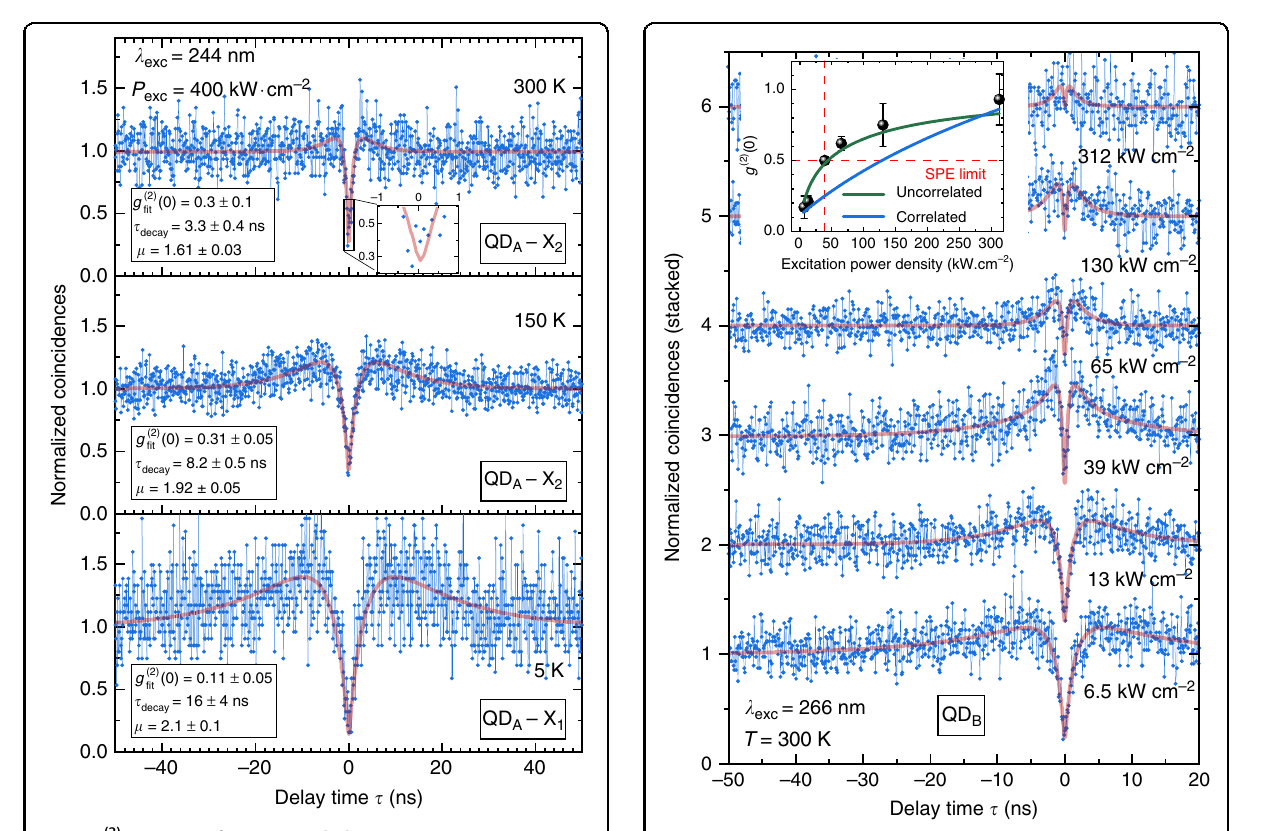
Fig. 5 g (2) ( τ ) traces of QD B recorded at 300 K as a function of excitation power density with a channel resolution of 100 ps/ channel (blue connected diamonds) and convoluted fi ts (red lines). Inset: evolution of the single-photon purity with rising excitation power density where the solid lines are the results issued from models assuming either an uncorrelated background (green line) or a correlated one (blue line). Adapted from Tamariz et al.